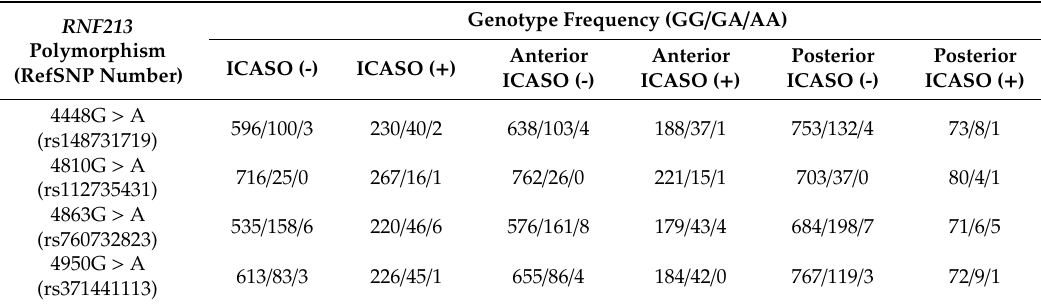
Table 3. Genotype distribution of RNF213 variants according to the presence of ICASO.